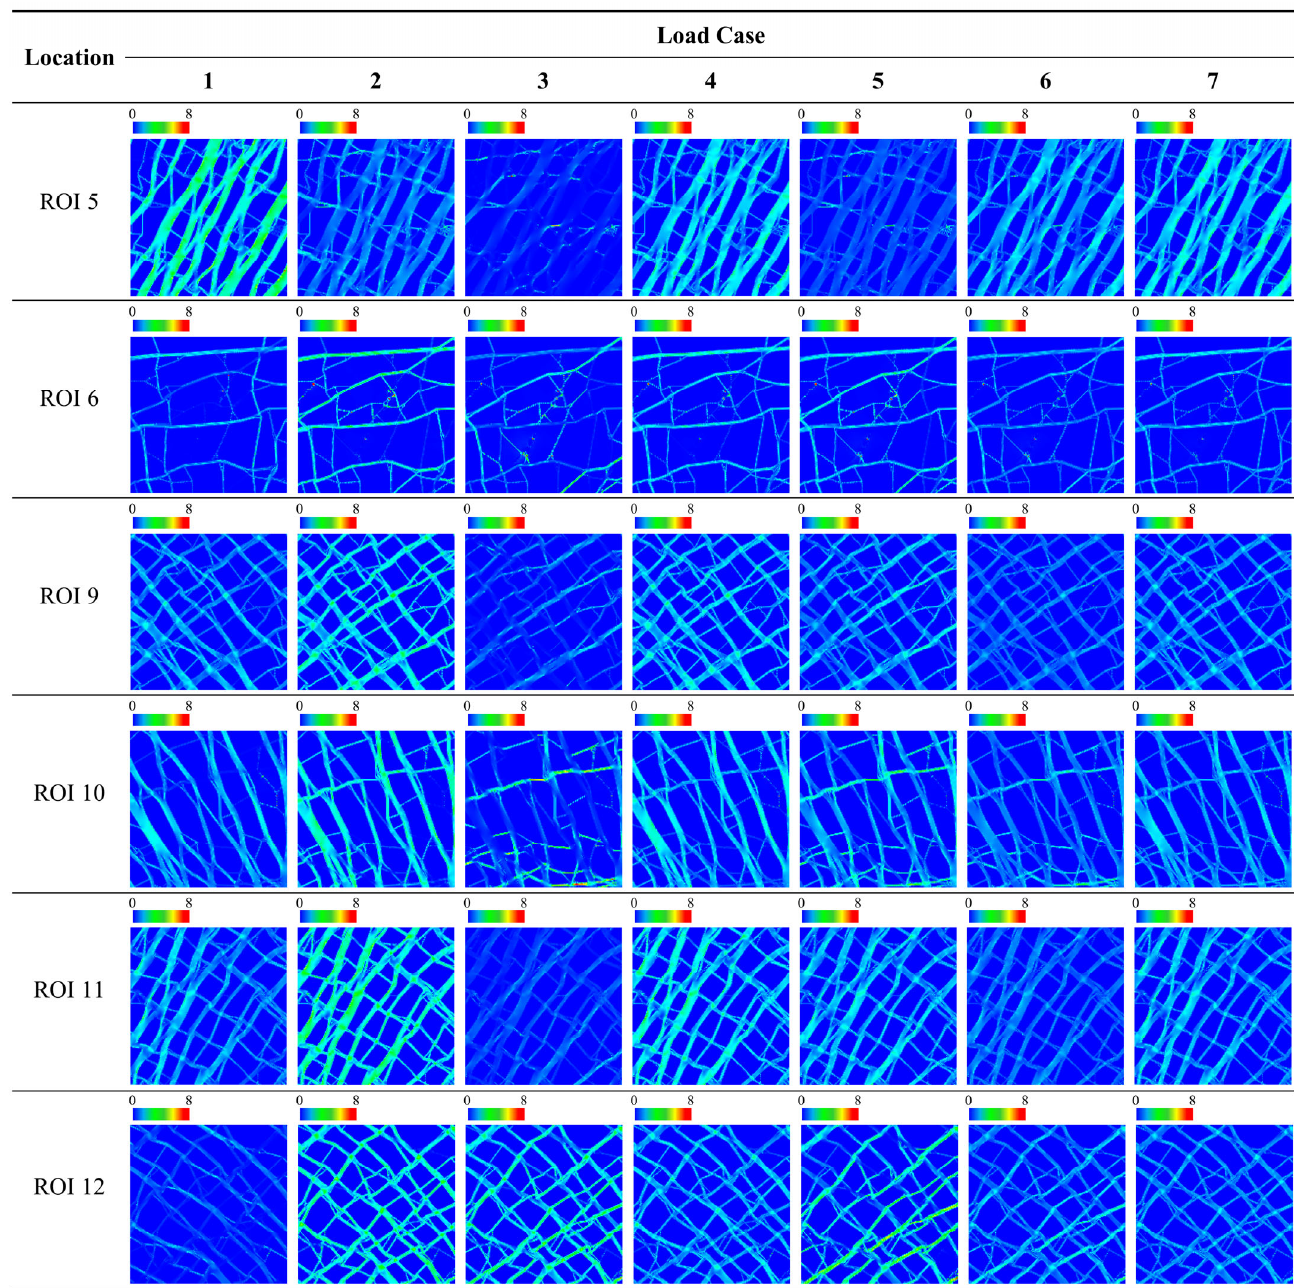
Figure 6. Strain energy density (J/mm 2 ) contour plots for ROIs in the metaphysis for each load case.